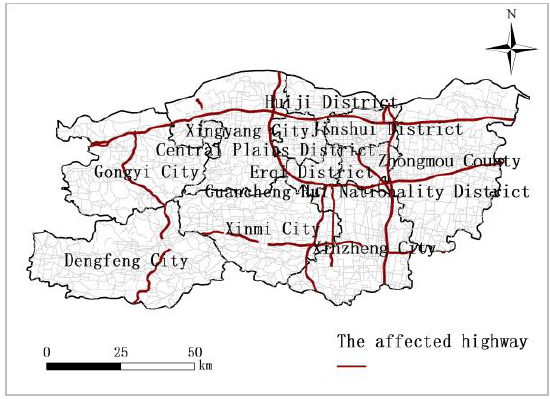
Figure 5 . Highway affected by rainstorm. Figure 5: As of 2021, Zhengzhou City has 11 transit highways, affected by heavy rainfall, expressways of Beijing-Hong Kong-Macao, Lian Huo, Zheng Shao, Zheng Min, Shang Deng, Zheng Jiao Jin, Jiao Tong, and other highways are affected to varying degrees, the overall situation of the affected highway shows the characteristics of a wide range of radiation over a large distance span.